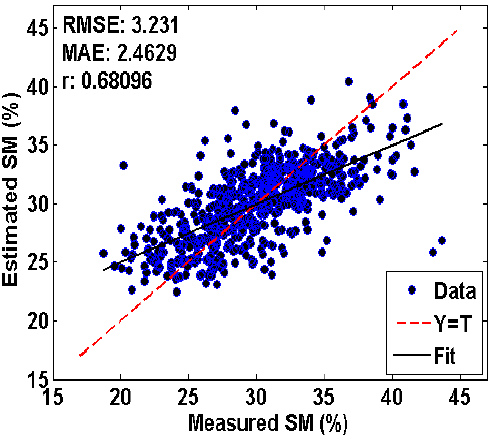
Figure 14. The relationship between measured and estimated SM for combined Datasets 1&2.